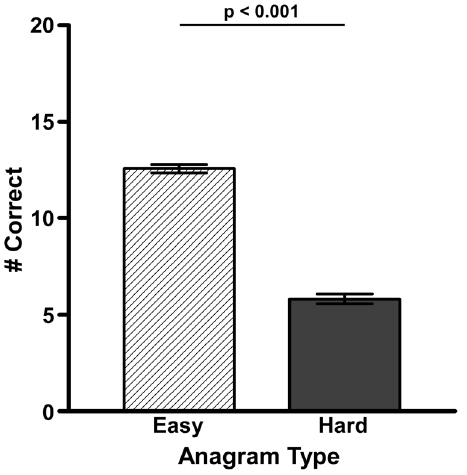
Figure 2. Average number of correct easy and hard anagrams. The average number of easy and hard anagrams that each participant completed correctly, regardless of which conversation they overheard.